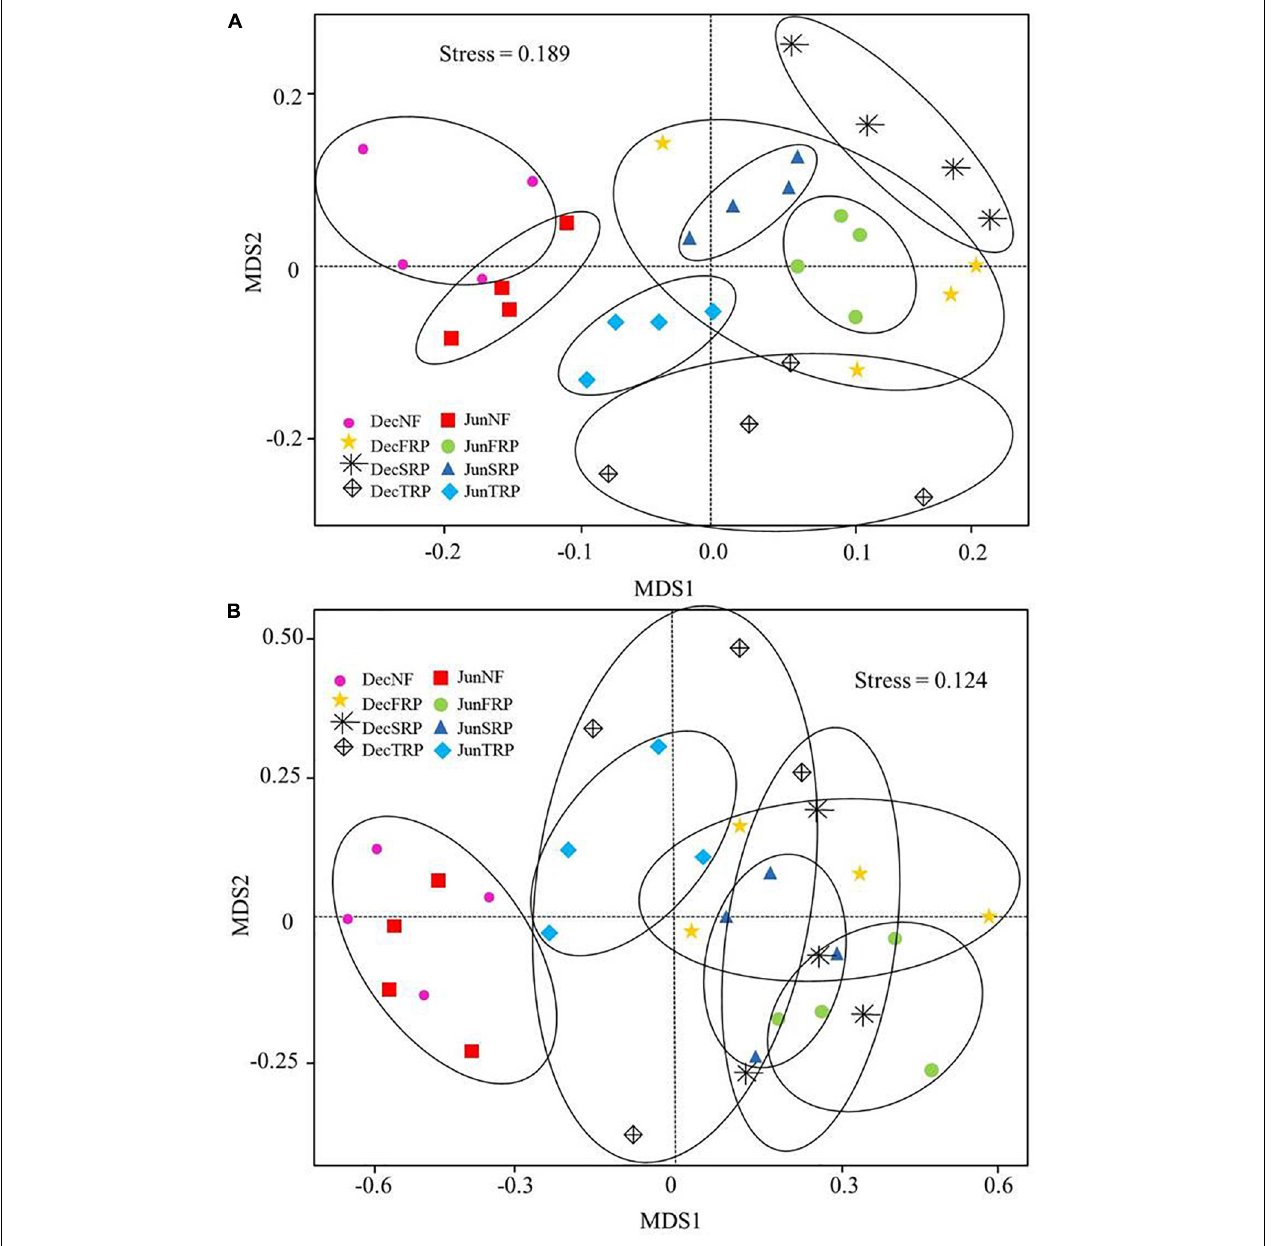
FIGURE 3 | Non-metric multidimensional (NMDS) scaling plot of bacterial (A) and fungal (B) community structure across all soil samples in different plantations and sampling times (using combined December and June data). Stress value is indicated in the figure. Data points are from different plantations and sampling seasons (NF, natural forest; FRP, first rotation plantation; SRP, second rotation plantation; TRP, third rotation plantation; Dec, December; Jun,